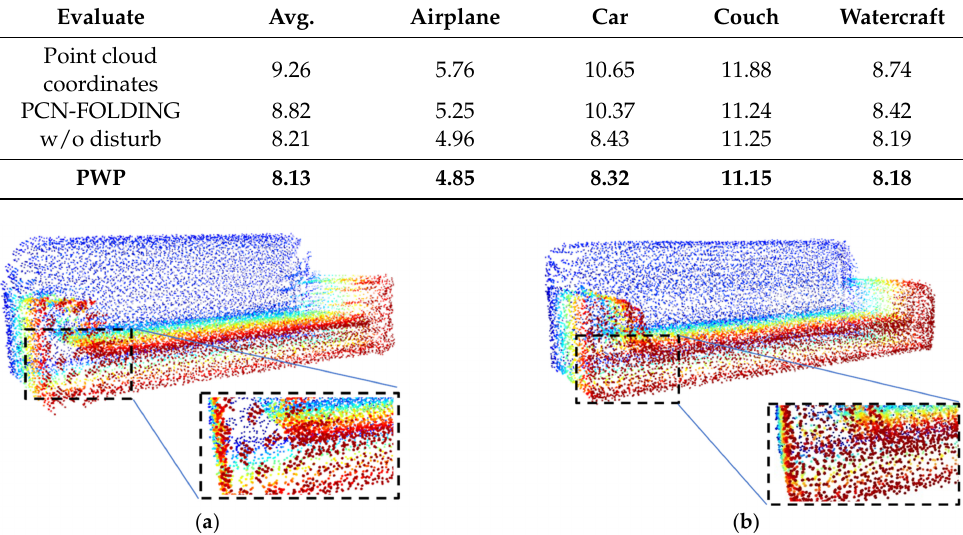
Figure 8. Visual comparison of our PWP structure and folding structure. ( a ) Folding, ( b )